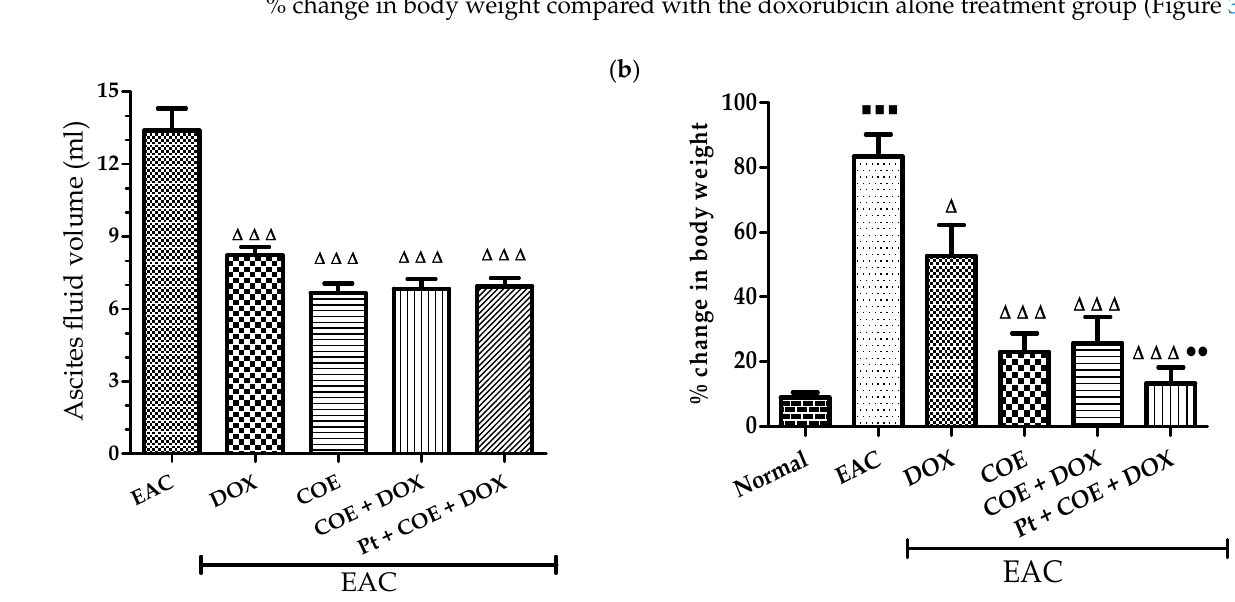
Figure 3. Effect of COE on ascitic fluid volume ( a ) and % change in body weight ( b ). All values are expressed as the mean ± SEM (n = 6). Data were analysed using one-way analysis of variance (ANOVA) followed by Tukey’s test. ▀ ▀ ▀ p < 0.001, compared with normal; Δ p < 0.05, Δ Δ Δ p < 0.001, compared with EAC; ●● p < 0.01 compared with DOX.